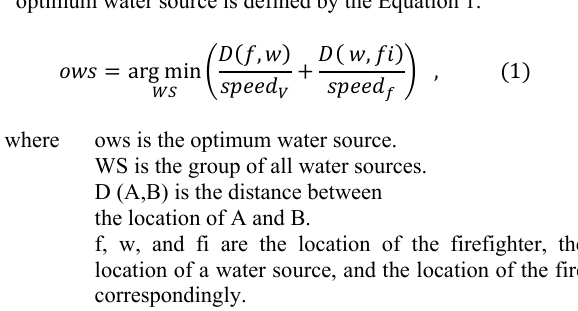
Figure 1. Firefighters’ model (Agent-based